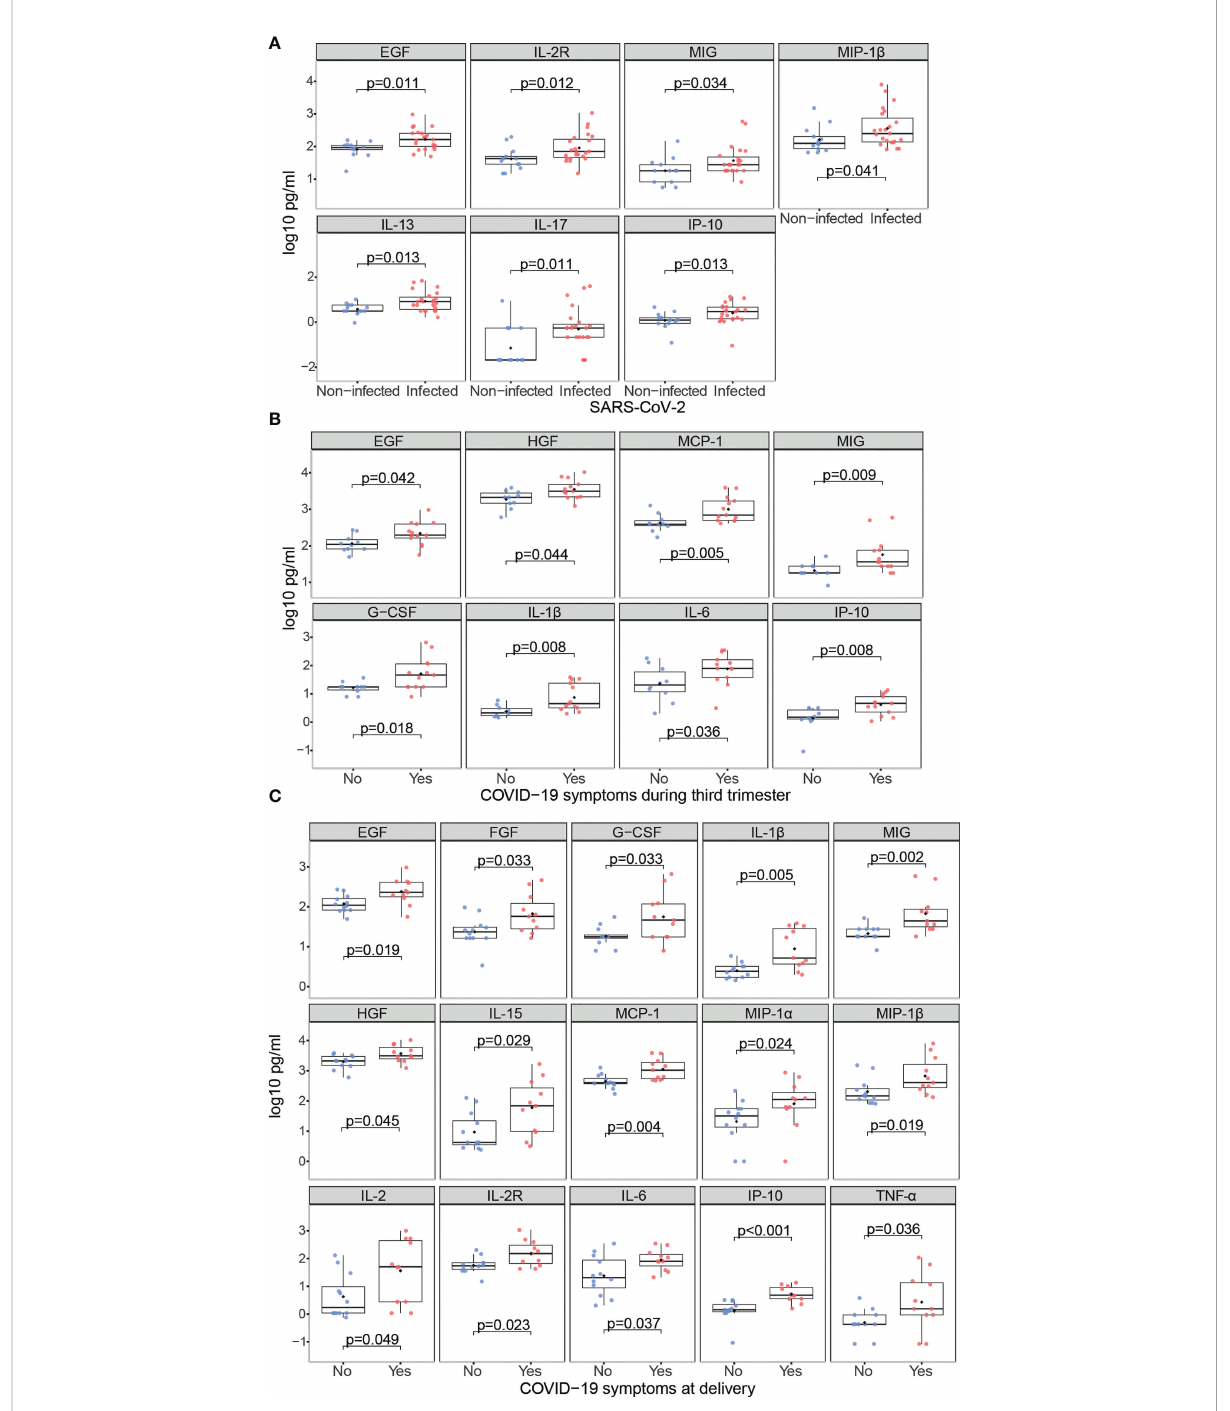
FIGURE 6 Cytokine, chemokine and growth factor concentrations in SARS-CoV-2 infected mothers. Comparison of in fl ammatory markers concentrations (log 10 pg/ml) in serum between (A) Infected (N=23, in red) vs. non-infected (N=13, in blue) mothers; (B) Infected symptomatic (N=13, in red) vs. asymptomatic (N=10, in blue) mothers during the third trimester; (C) Infected symptomatic (N=11, in red) vs. asymptomatic (N=12, in blue) mothers at delivery. Groups were compared by the Wilcoxon-rank-sum-test. Only signi fi cant comparisons are shown, the remaining are in Figures S6 –